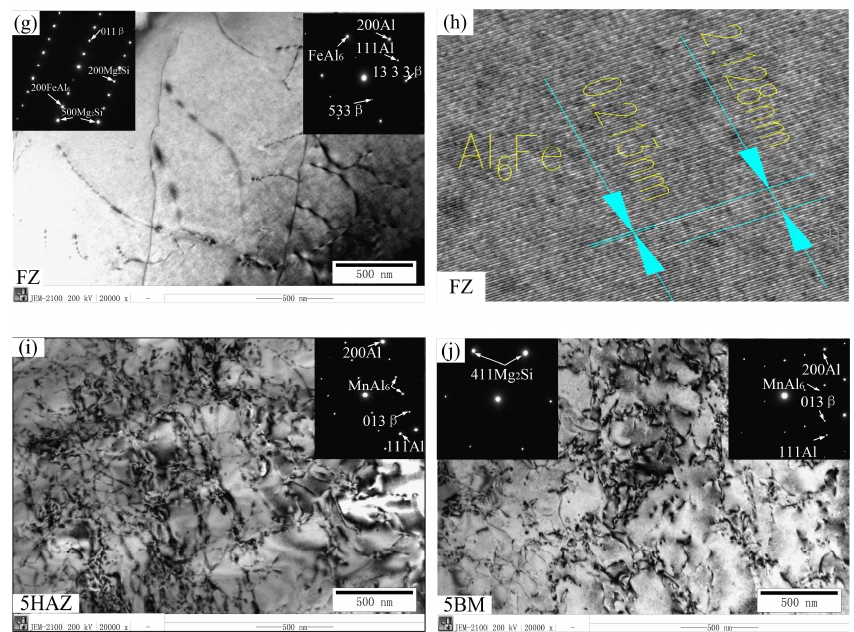
Figure 9. TEM study of the microstructure of different parts of the two alloys in the weldment: ( a–c ) microstructure of the base metal (7BM); ( d–f ) microstructure of the heat-affected zone (7HAZ) adjacent to the base metal; ( g,h ) microstructure of the fusion zone; ( i ) microstructure of the heat-affected zone (5HAZ) adjacent to the base metal; ( j ) microstructure of the base metal (5BM).